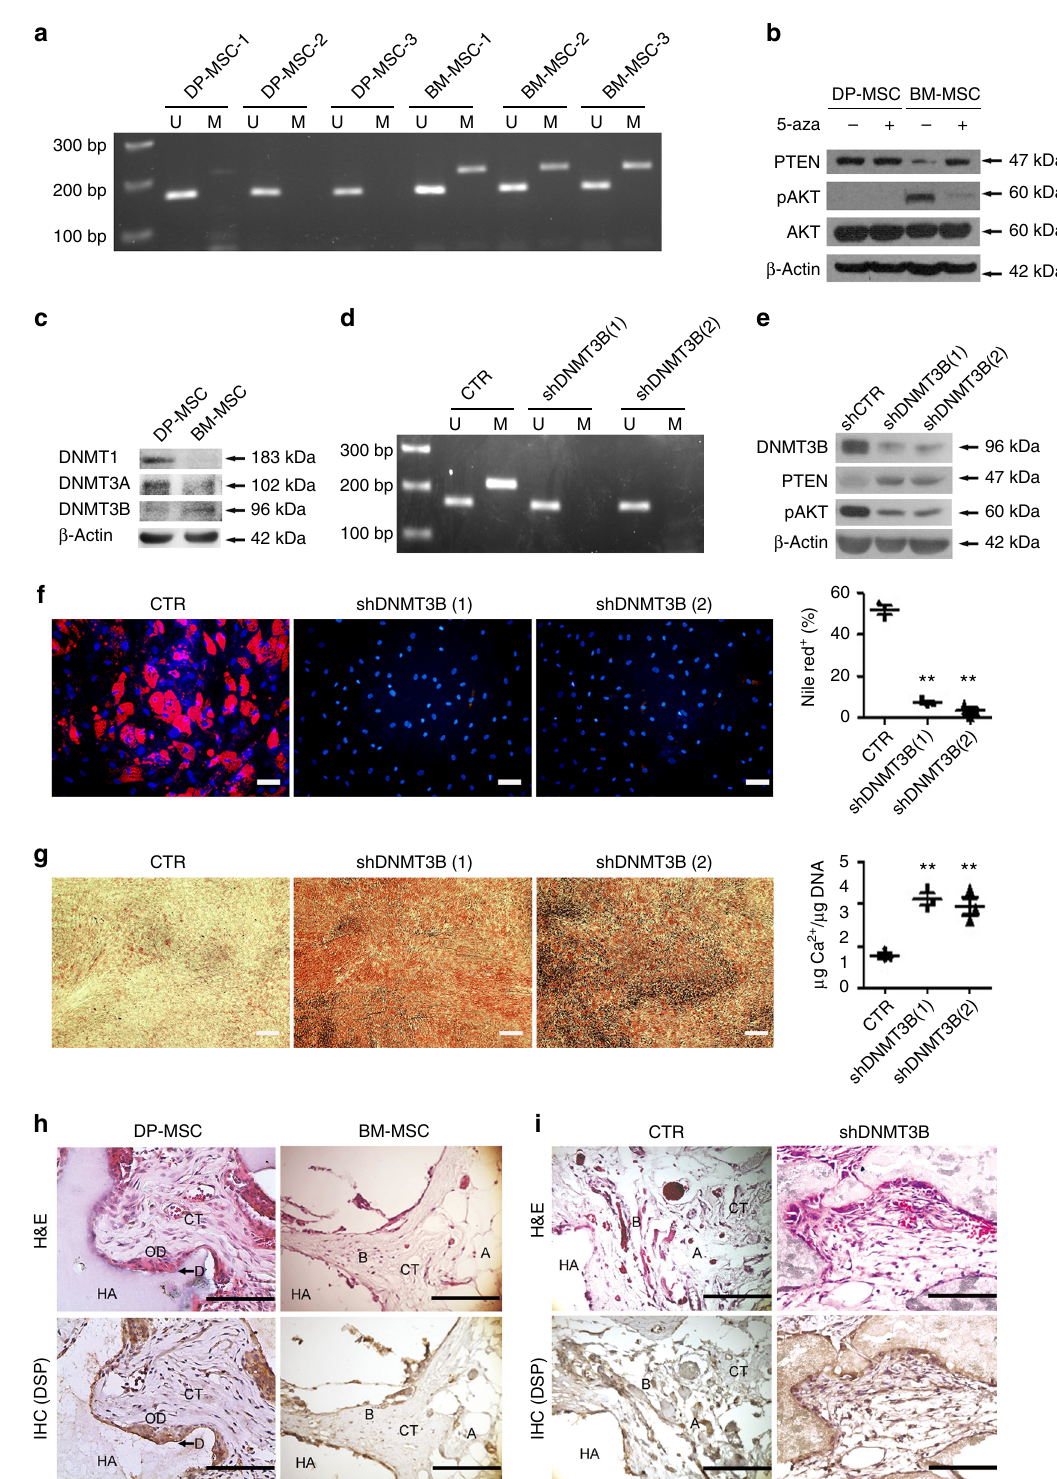
BM-MSCs than in DP-MSCs (Fig. 5c). Knocking down DNMT3B in BM-MSCs decreased the level of DNA methylation at the PTEN promoter (Fig. 5d), upregulated PTEN expression, and decreased AKT phosphorylation (Fig. 5e). Furthermore, as expected, DNMT3B knockdown inhibited adipogenic potential (Fig. 5f) and increased osteogenic potential in BM-MSCs (Fig. 5g). DP-MSCs form a dentin pulp-like complex after sub- cutaneous transplantation in vivo 9 . In agreement with